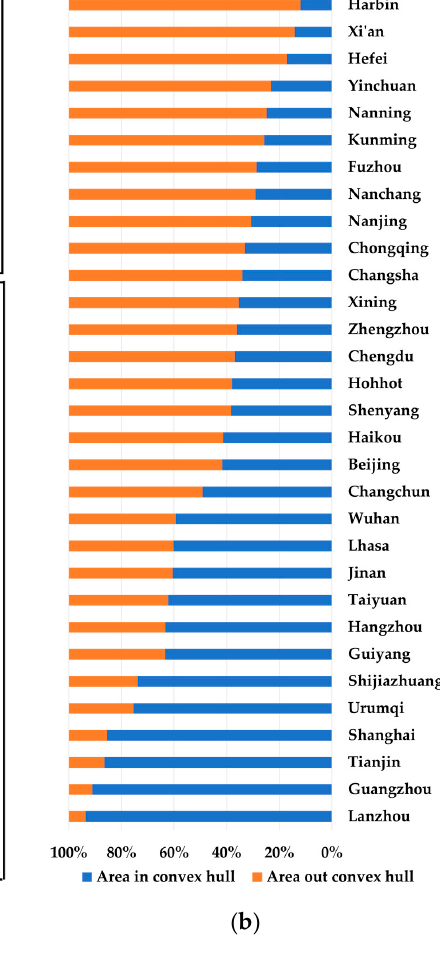
Figure 10. Expansion types of capital cities in China from 2000 to 2015.